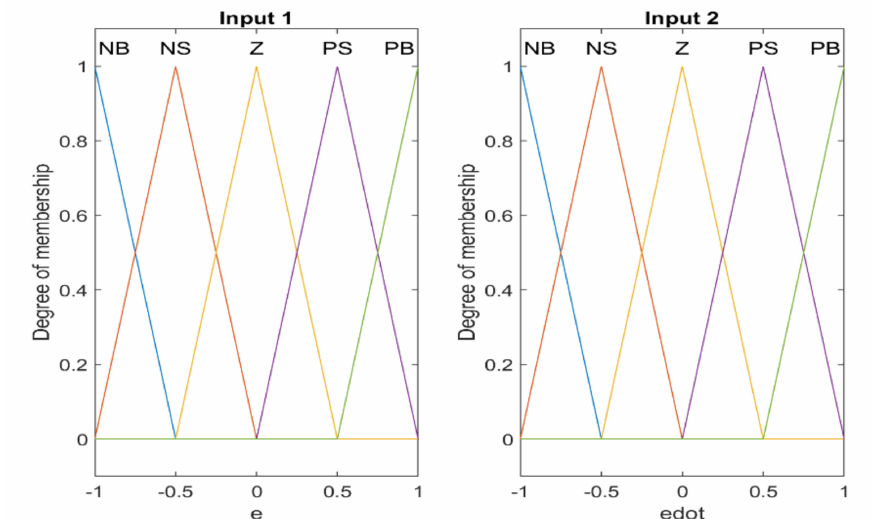
Figure 4. Input membership functions of the fuzzy systems.